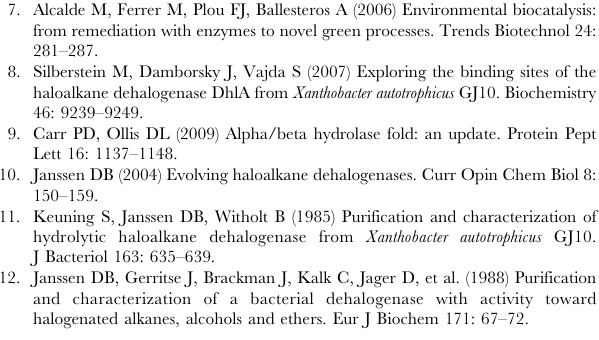
10.0). Figure S6, Secondary structure elements prediction of HLDs. Sequences of DadB and other 7 HLDs with crystal structures [8,11,21–25] were submitted to PRIPRED server (http://bioinf.cs.ucl.ac.uk/psipred/). And multiple sequence alignment was conducted by ClustalX2.1[1]. The fragments in blue, magenta and yellow background represent the realistic (7 HLDs with solved structures) or predicted (homology modeling of DadB) b -sheets, a - helices and coiled coils respectively. The blue, magenta and yellow letters means they are belong to b -sheets, a - helices and coiled coils according to the Secondary structure elements prediction. Figure S7, Three-dimensional structure model of DadB. The cyan and green elements constitute the cap domain and the main domain, respectively. The yellow, red, magenta, blue represents the halide-binding residues, the nucleophile residue, the acid residue, and the base residue, respectively. Table S1, Halogenated substrates used in the activity determination. Table S2, Oligonucleotides used for gene cloning and vector construction. Table S3, Conditions used in determination of steady-state kinetic constants by gas chromatography. Table S4, Similarity matrix of DadB and other HLDs